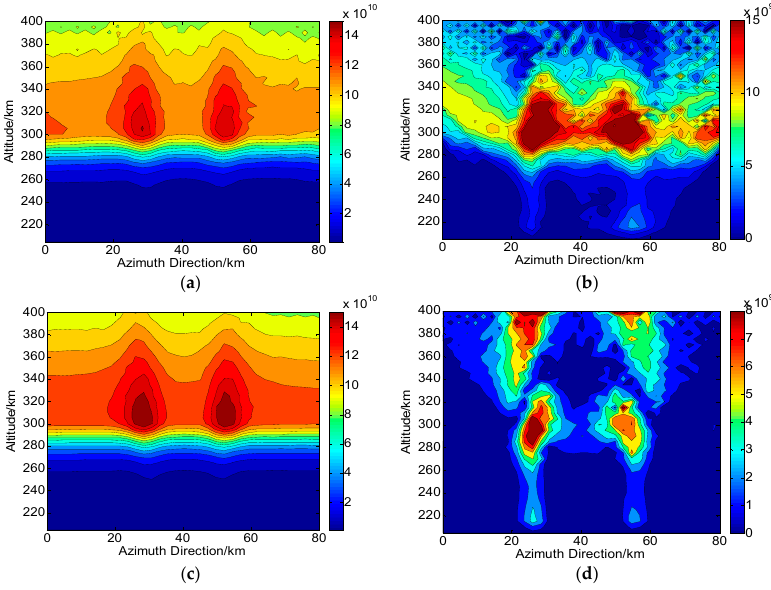
Figure 15. Two-dimensional CIT reconstructions under the condition of crosstalk in Changbai ( F Ω